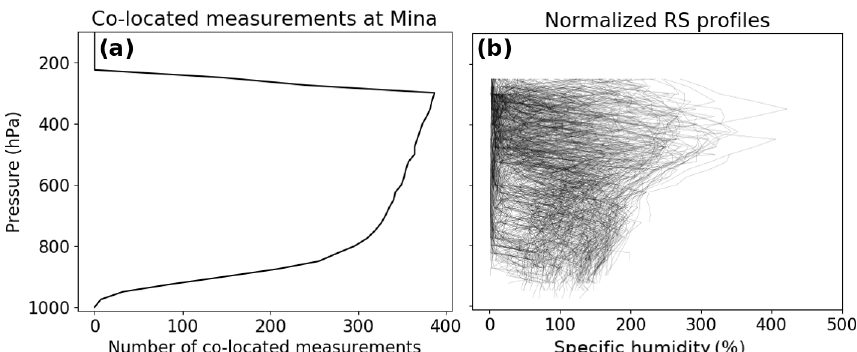
Figure 11. (a) Number of co-located measurements (data pairs) per pressure level for RO, RS and ERA. (b) Normalized q values for radiosondes (RS) at Mina, 2007. The normalized q values are computed as 100 · q/q , where q is the annual mean value of q for 2007. Profiles cut off at 250hPa because RS data are not reported at higher levels. At the bottom, co-located profiles thin out since RO penetration depth varies and only very few profiles are available at the lowest levels.